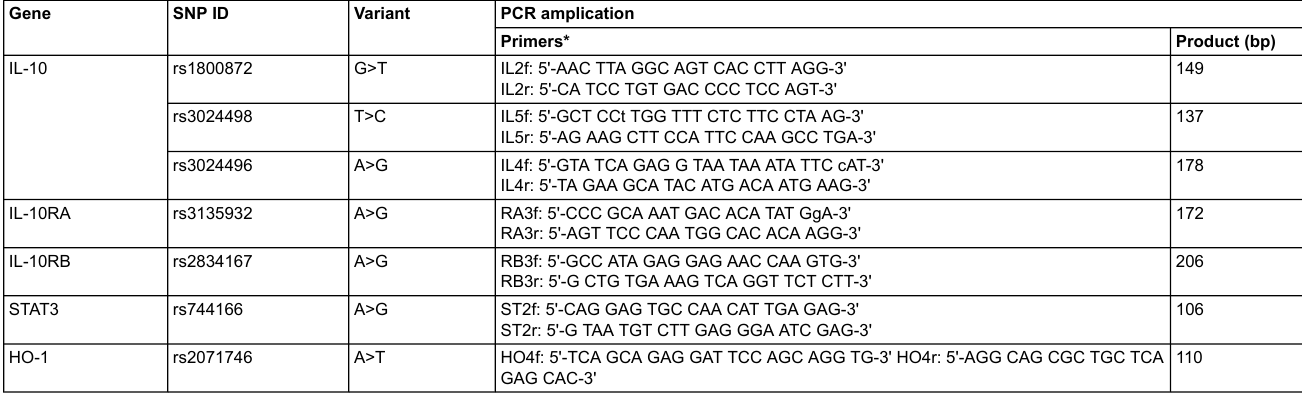
Table 3: PCR primers for seven SNPs from genes IL-10, IL-10RA, IL-10RB, STAT3 and